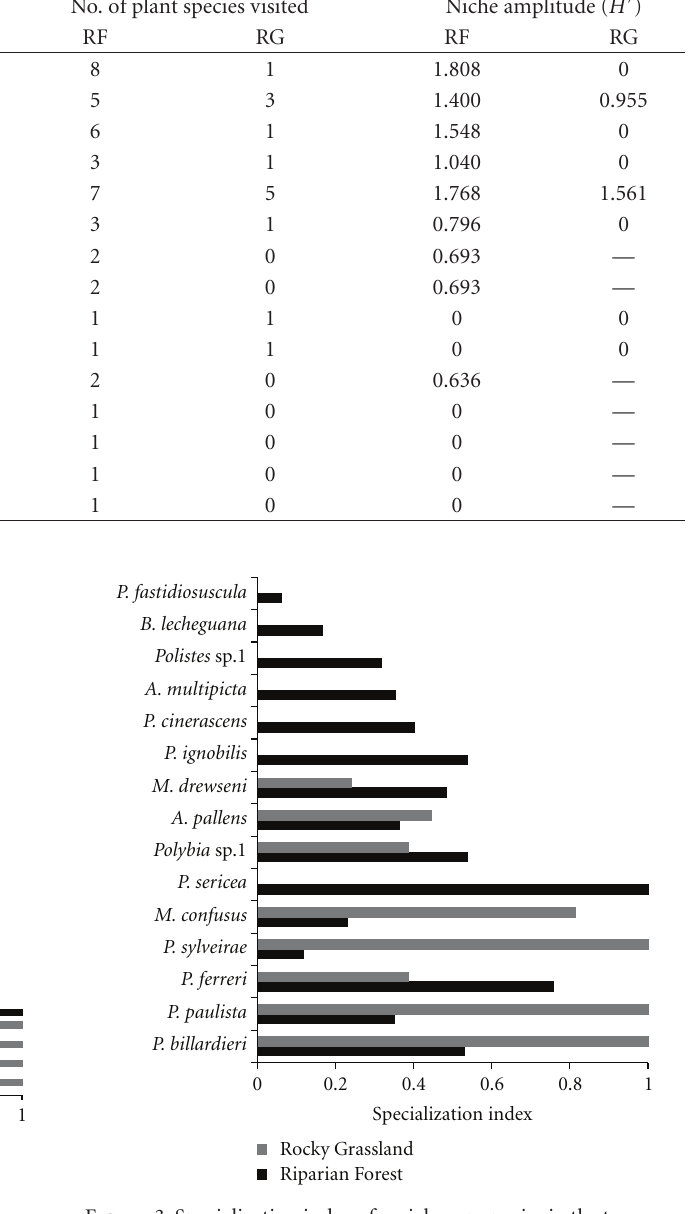
Table 2: Abundance, number of plant species visited, and niche amplitude of the species of social wasps collected in Ibitipoca State Park, MG, Brazil, during the period from November 2007 to October 2008. “RF” means Riparian Forest and “RG” means Rocky Grassland. See Table 3 for the classification and authors of species. Abundance of individuals Wasp species